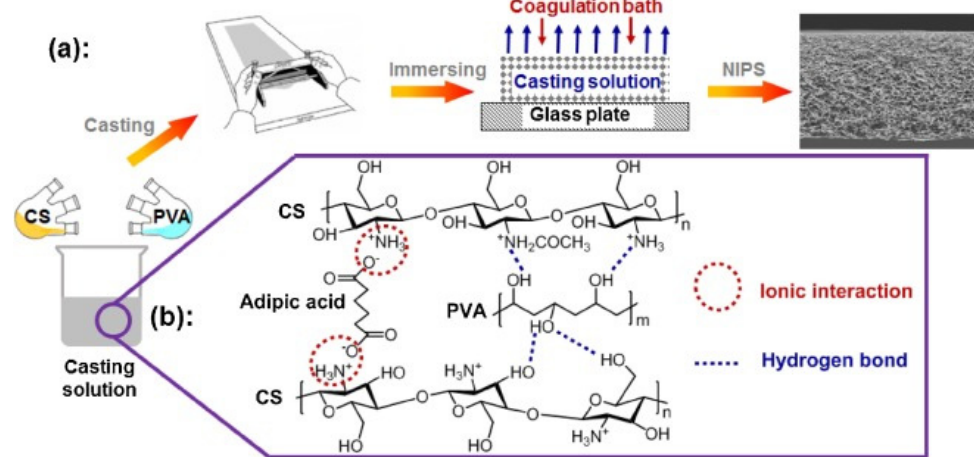
Figure 7. ( a ) Schematic of preparation process of Chit/PVA blend membranes. ( b ) Proposed interactions among Chit, PVA and adipic acid in the casting solution. Reprinted from [152] with permission from Elsevier.